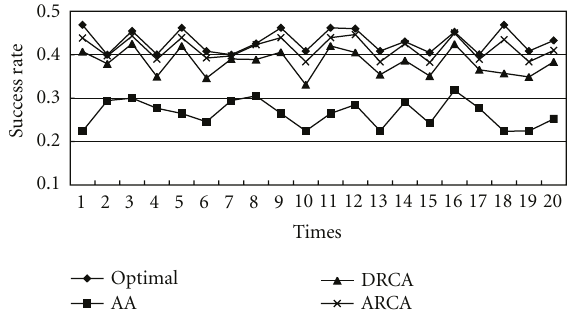
Figure 1: Total transmission success rate in Case 1.